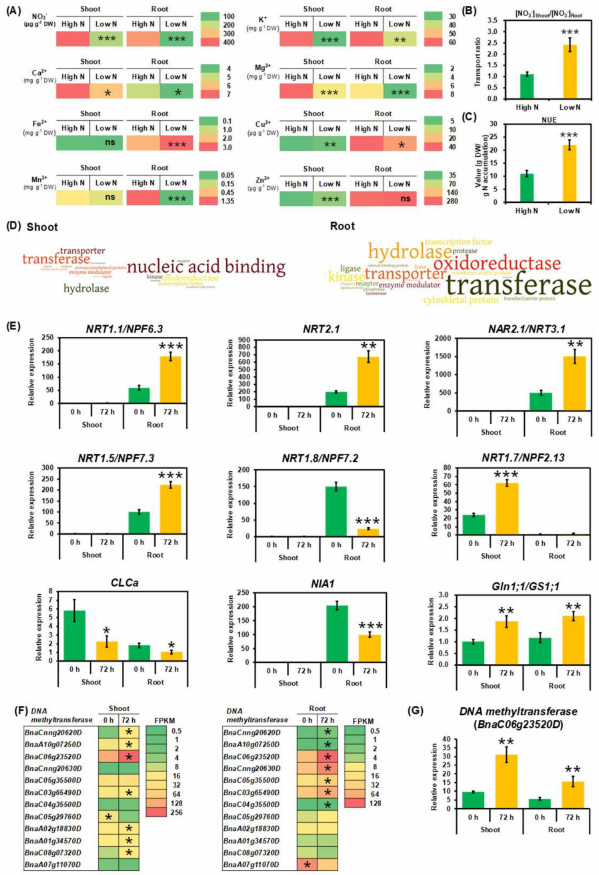
Figure 2. Ionomic and transcriptional responses of rapeseed plants to N limitation. ( A ) Ionomic profiling of rapeseed plants under N limitation, including the concentrations of nitrate (NO 3 − ), potassium (K + ), calcium (Ca 2 + ), magnesium (Mg 2 + ), iron (Fe 2 + ), copper (Cu 2 + ), manganese (Mn 2 + ), and zinc (Zn 2 + ) in the shoots and roots of rapeseed plants. ( B ) Ratio of nitrate concentrations in the shoots to those in the roots. ( C ) N use e ffi ciency (NUE). NUE = total plant dry weight (g) / total plant N accumulation (g). ( D ) Gene Ontology (GO) enrichment analysis of the genes responsive to N limitation in the shoots and roots. The larger the font sizes, the more enriched the GO terms. ( E ) The qRT-PCR assay-assisted relative expression of some key N-metabolism-associated genes, including NRT1.1 / NPF6.3 , NRT2.1 , NAR2.1 / NRT3.1 , NRT1.5 / NPF7.3 , NRT1.8 / NPF7.2 , NRT1.7 / NPF2.13 , CLCa , Gln1;1 / GS1;1 , and NIA1 . ( F ) RNA-Seq assisted transcriptomic profiling of the di ff erentially expressed DNA methyltransferase genes. Di ff erentially expressed genes with higher expression between di ff erent treatments in the shoots or roots are indicated with asterisks. ( G ) RT-qPCR-assay-assisted relative expression of a DNA methyltransferase gene (BnaC06g23520D). For ( A – C ), rapeseed plants were hydroponically grown under high nitrate (6.0 mM NO 3 − ) and low nitrate (0.3 mM NO 3 − ) for 10 days until sampling, respectively. For ( D – G ), rapeseed plants were hydroponically grown under high nitrate (6.0 mM NO 3 − ) for 10 days, and then they were transferred to high nitrate and low nitrate (0.3 mM NO 3 − ) for 72 h until sampling, respectively. The times of 0 h and 72 h refer to the times after treatment of N deficiency. Columns denote means ( n = 3), and error bars indicate standard deviations. *, p < 0.05; **, p < 0.01; ***, p < 0.001; ns, not